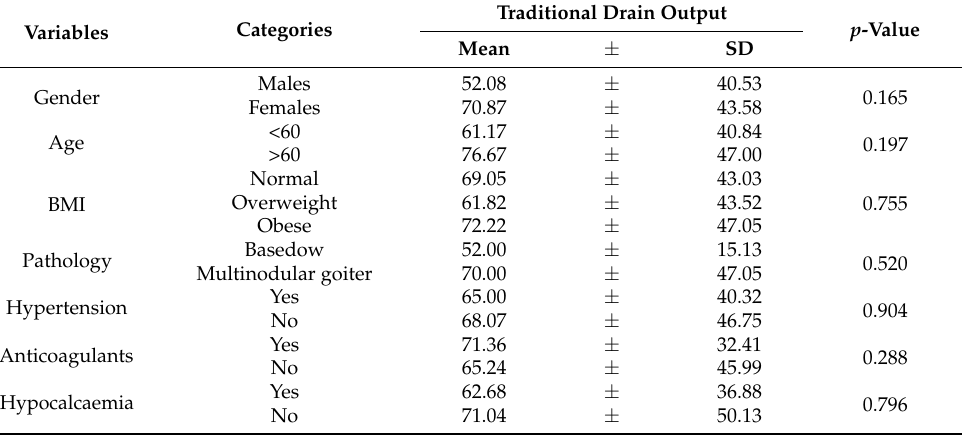
Table 4. Analysing variables influencing Drain output for traditional group. Abbreviation: BMI: Body Mass